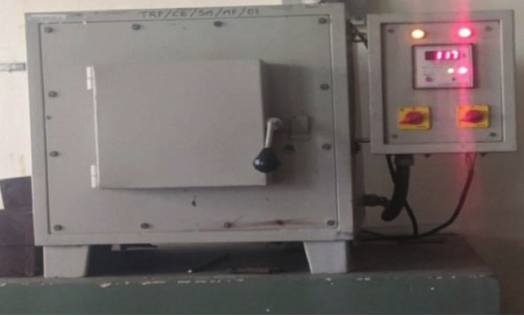
Figure 1: Heat treatment by muffle furnace KSM-0012.